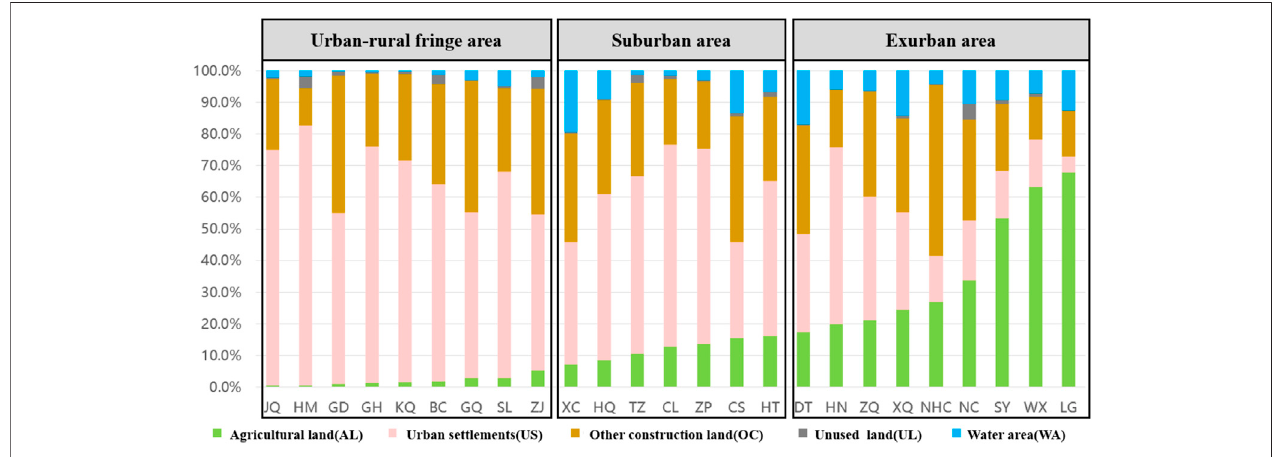
FIGURE 5 | Spatial distribution of CSS at the township level in Pudong from 2000 to 2018.